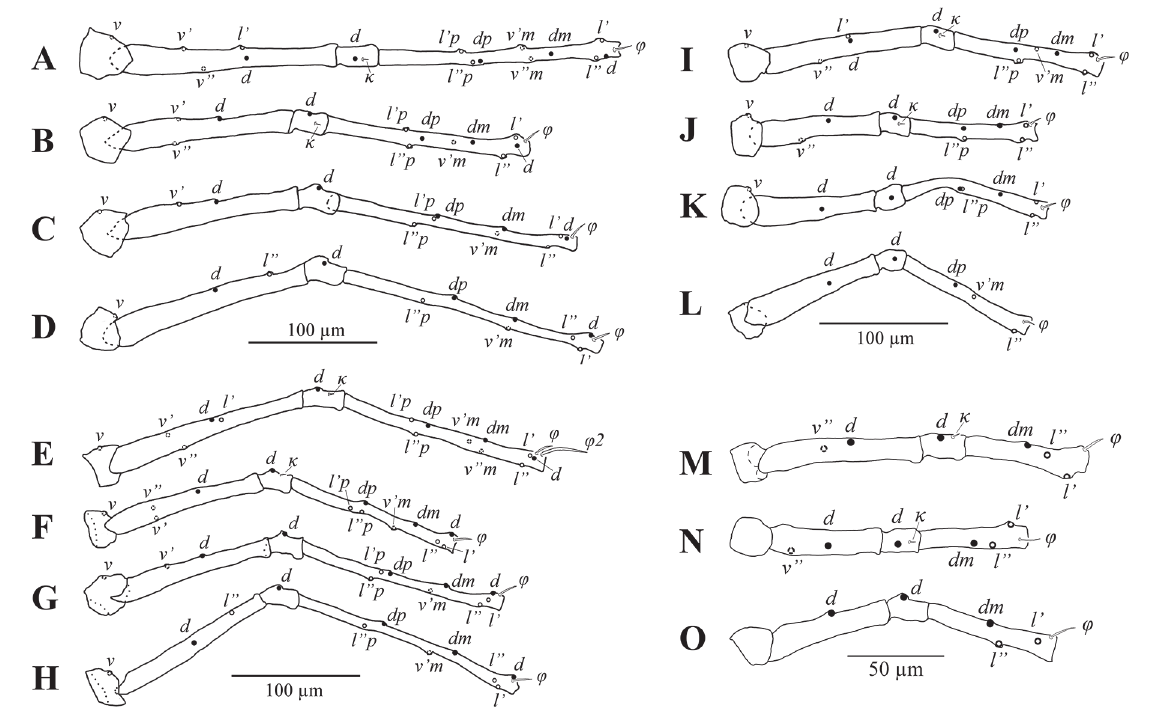
Fig. 3. Schematic leg setations of Neophyllobius cibyci sp. nov. A–D . ♀, holotype. A . Trochanter–tibia